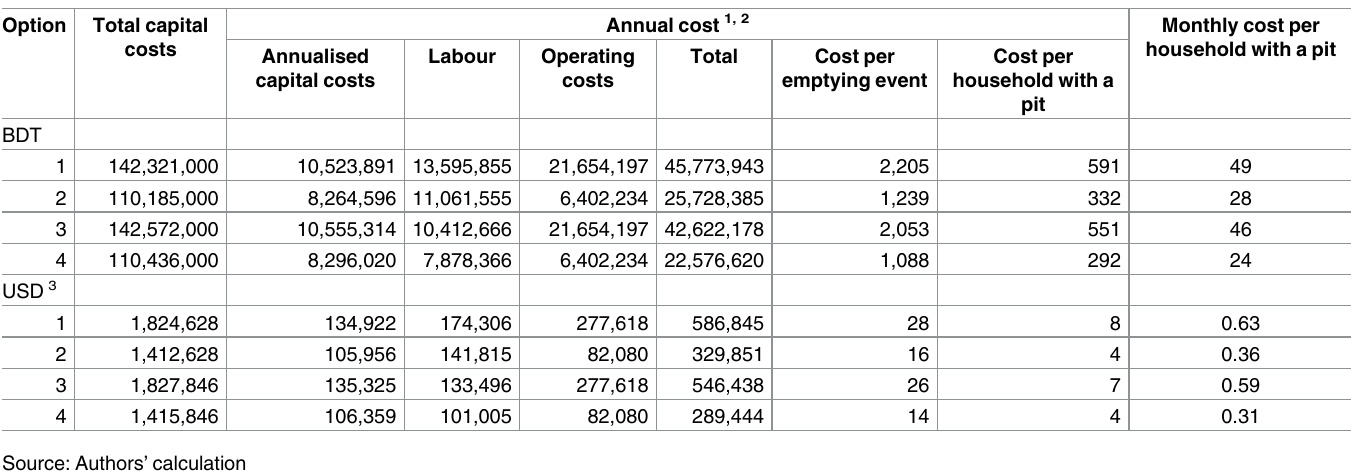
Table 7. Summaryof